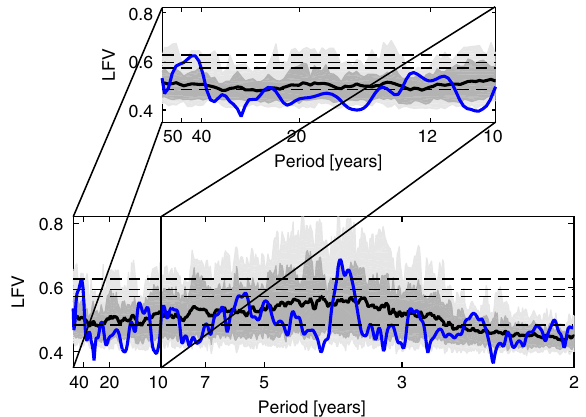
Fig. 1 Spectra for the global surface temperature fi elds from control CMIP5 simulations and historical observations. Shading with mean over all model simulations is shown by black curve and historical result is shown by blue curve. Dark grey region bounds 68% of the simulations while light grey region bounds 95% of the simulations. Lower ( f = 0.015 cycle/year) and upper ( f = 0.5 cycle/year) bound on frequencies shown correspond to edge of secular band and Nyquist sampling frequency. Inset zooms in on the decadal ( f = 0.1 cycle/year) and longer periodicities. Horizontal dashed lines correspond to median ( p = 0.5) and p = 0.1, 0.05 and 0.01 signi fi cance levels relative to coloured noise null hypothesis. Local Fractional Variance